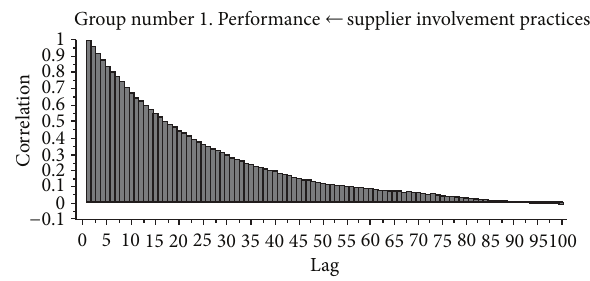
Figure 5: Shows the autocorrelation plot of supplier involvement practices → NPD project